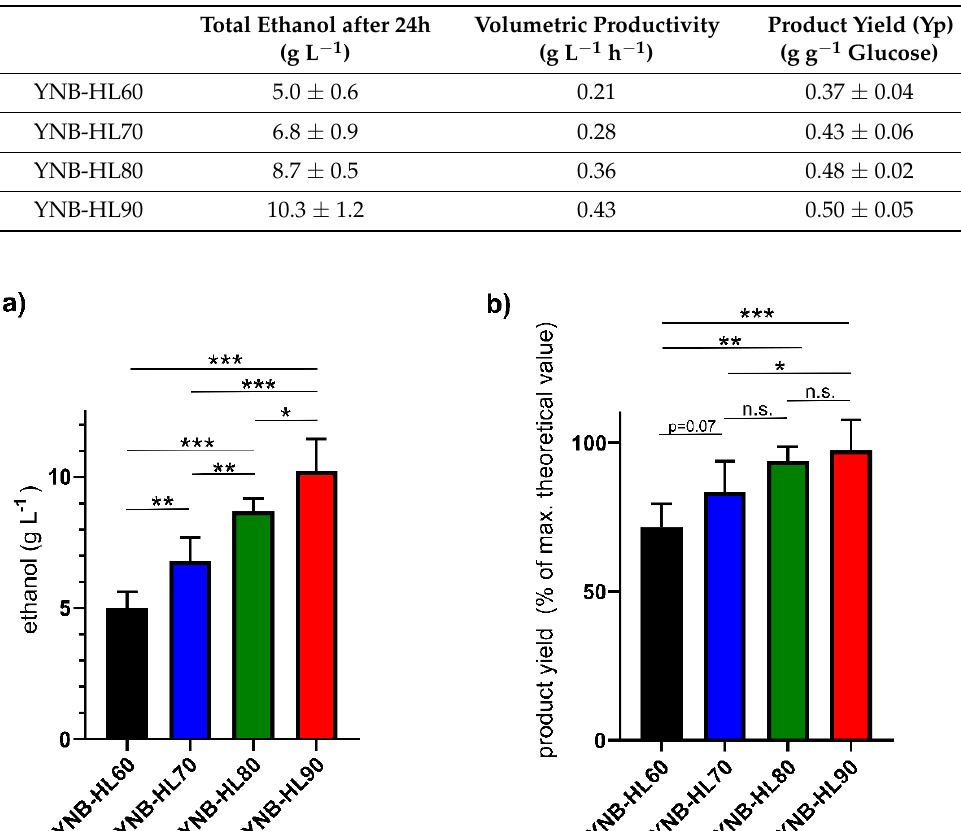
Figure 5. Ethanol production of I. orientalis KJ27-7 from WSHL. Ethanol yield (as determined by HPLC) of I. orientalis KJ27-7 after 24 h cultivation at 26 °C in YNB media containing 60% (black), 70% (blue), 80% (green) or 90% (red) WSHL as the sole carbon source. ( a ) absolute values in g L −1 ; ( b ) product yield (Yp) in percent of maximum theoretical ethanol yield. Displayed are mean values ± SD of four independent experiments, each performed in duplicates. Asterisks indicate p -values (** = p < 0.005, * = p < 0.05 and *** = p < 0.001).